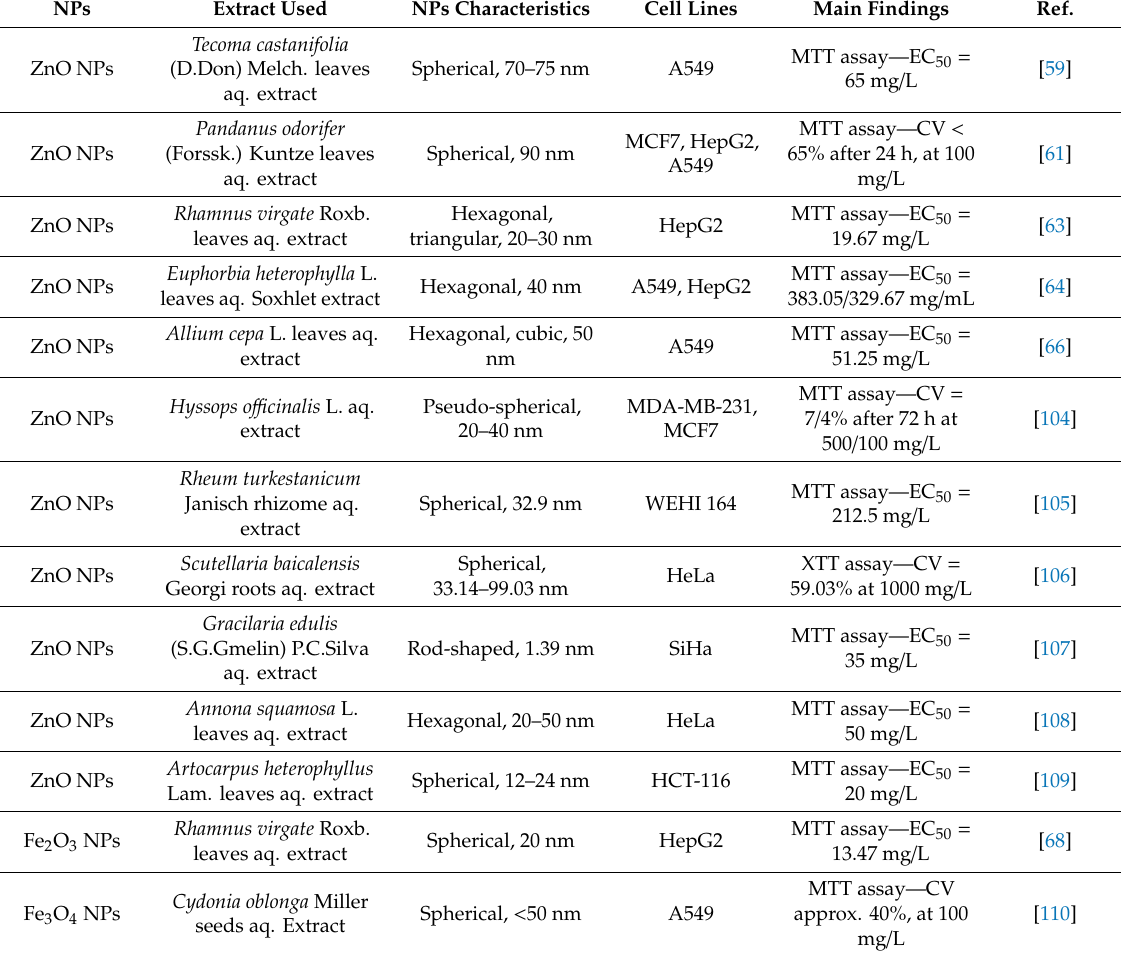
Table 4. Antitumoral potential of other phytosynthesized nanoparticles (as presented in studies published in